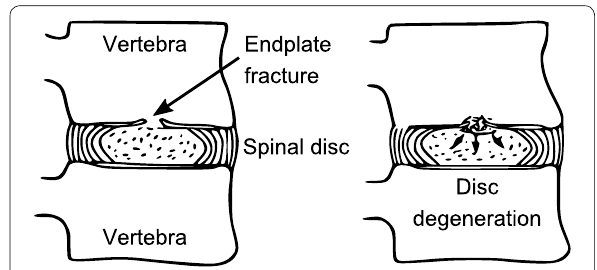
Fig. 1 End‑plate fracture initiates disc degeneration (adapted from the work of Bogduk